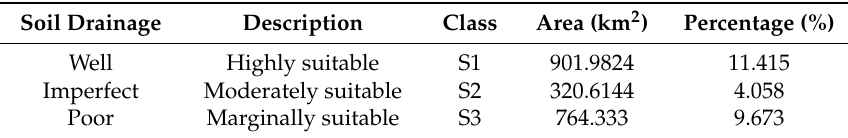
Table 6. Land suitability based on drainage.